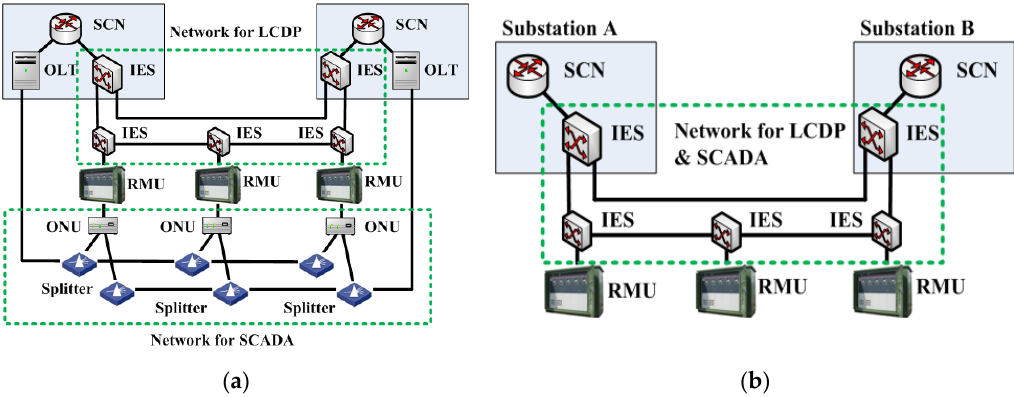
Figure 1. The communication mode ( a ) integration with Ethernet passive optical network (EPON) and ( b ) integration with industrial Ethernet system (IES).